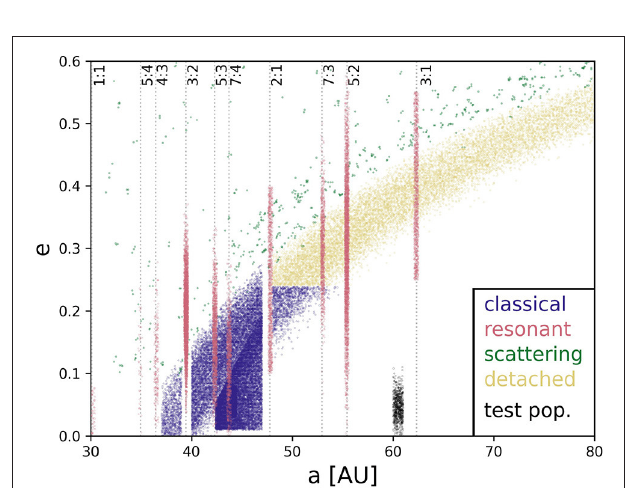
FIGURE 4 | Colored points show the relative populations and semimajor axis-eccentricity distributions from the CFEPS L7 model of the Kuiper belt, where absolute population estimates have been produced for each subpopulation in the well-characterized CFEPS survey (Petit et al., 2011; Gladman et al., 2012), populations are scaled to H g < 8.5 and color-coded by dynamical class. Resonances included in this model (those with > 1 TNO detected by CFEPS) are labeled. A low- e artificial test population has been injected at 60 AU (black points); the number of points shows the upper limit on this population determined by zero detections in OSSOS, extrapolated to match the CFEPS model ( H r < 8).